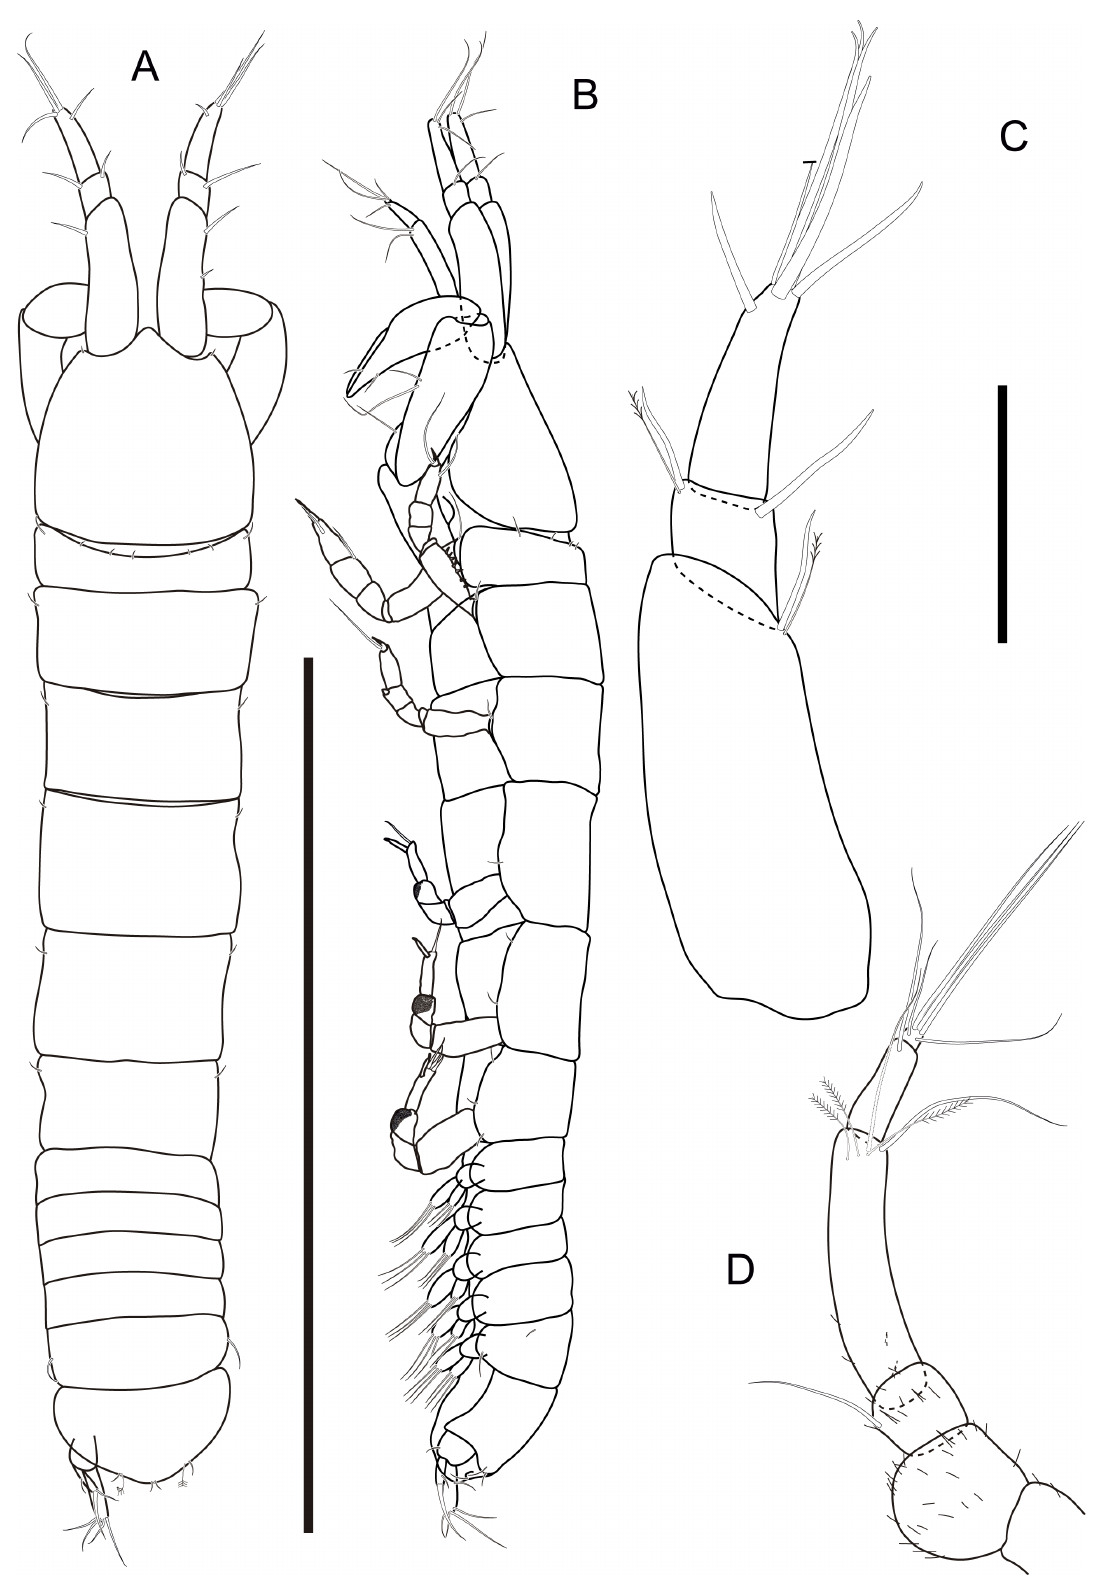
Fig. 8. Typhlotanais bolarticulus sp. nov. A . ♀ (MNRJ 18328), dorsal view. B–D . Paratype (MZUSP 32878), ♀, dissected. B . Lateral view. C . Antennule. D . Antenna. Scale bars: A–B = 1 mm; C–D = 0.1